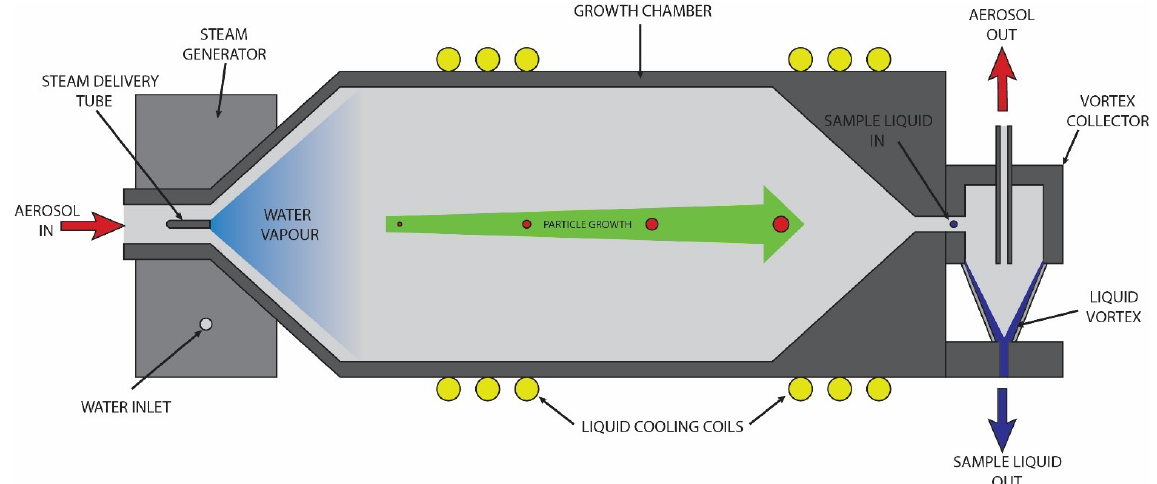
Figure 2. Diagram of the PINQ insoluble aerosol collector (IAC), showing key components including the aerosol inlet, steam generator, growth chamber, and vortex